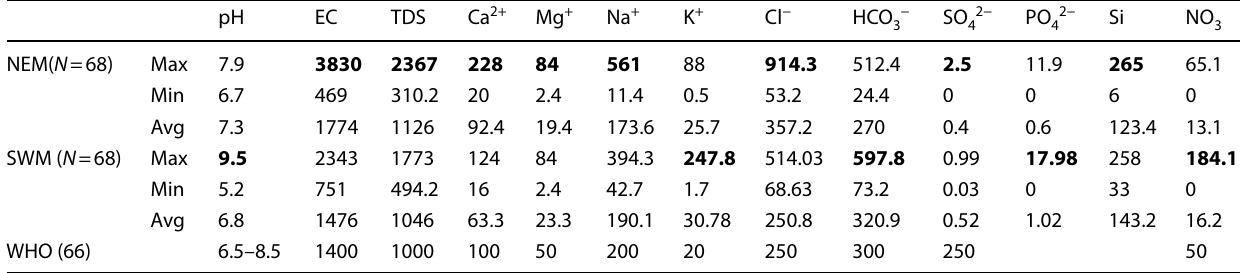
Table 3 Evaluation of physico-chemical parameters of collected groundwater samples (all values in mg/l except pH, temperature (ºC) and EC (µS/cm)). The numbers in bold indicate the highest value